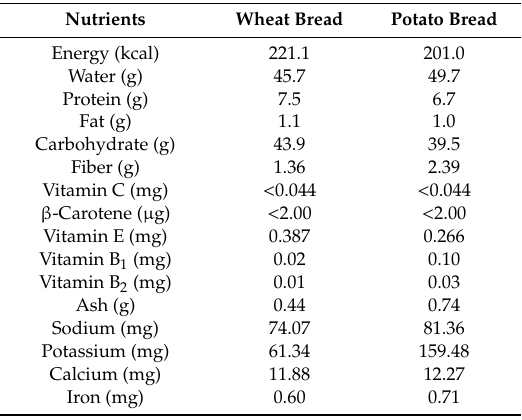
Table 1. Nutritional content of two types of steamed bread (100 g).